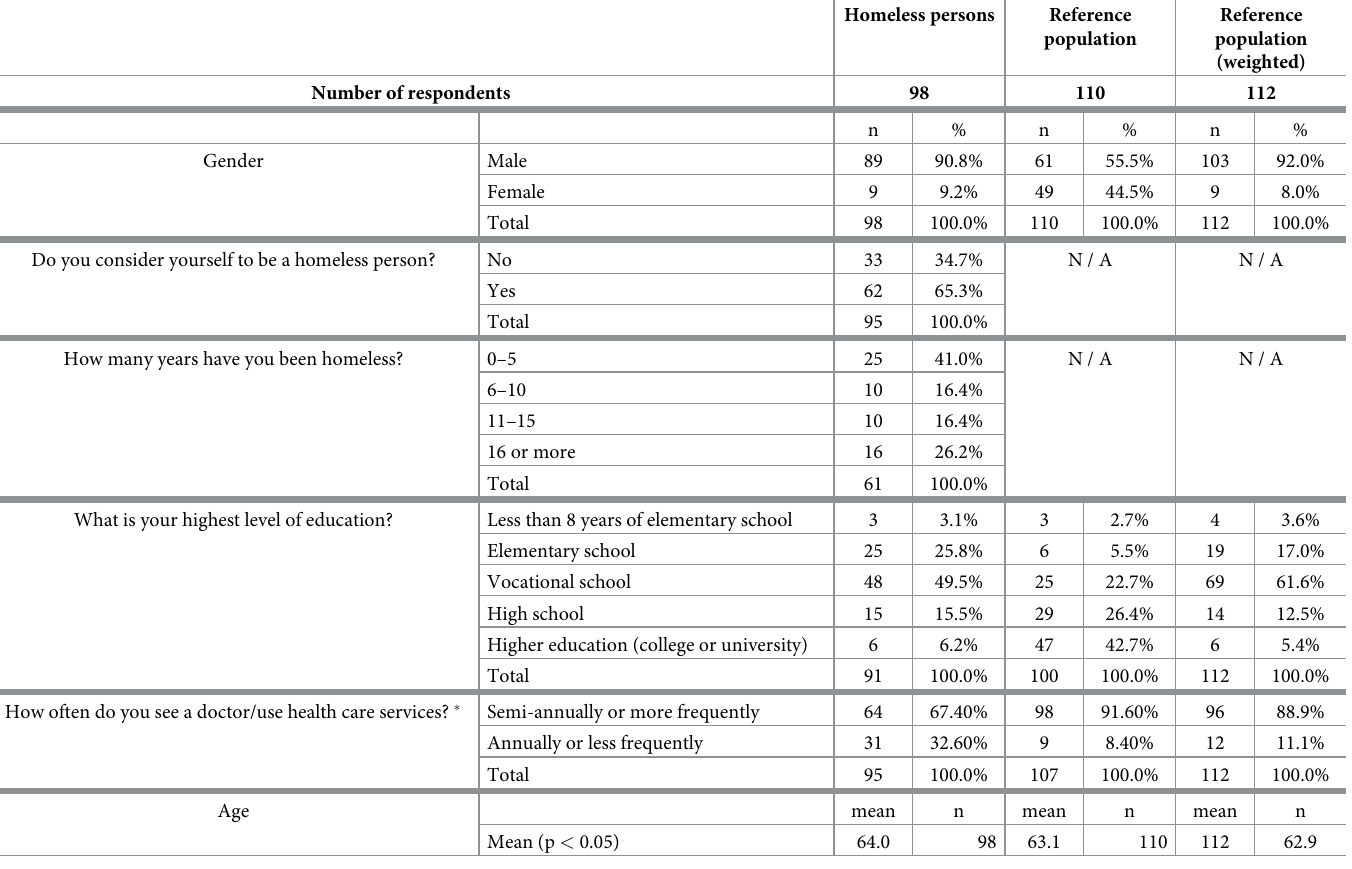
Table 2. Main demographic characteristics of the index and the reference